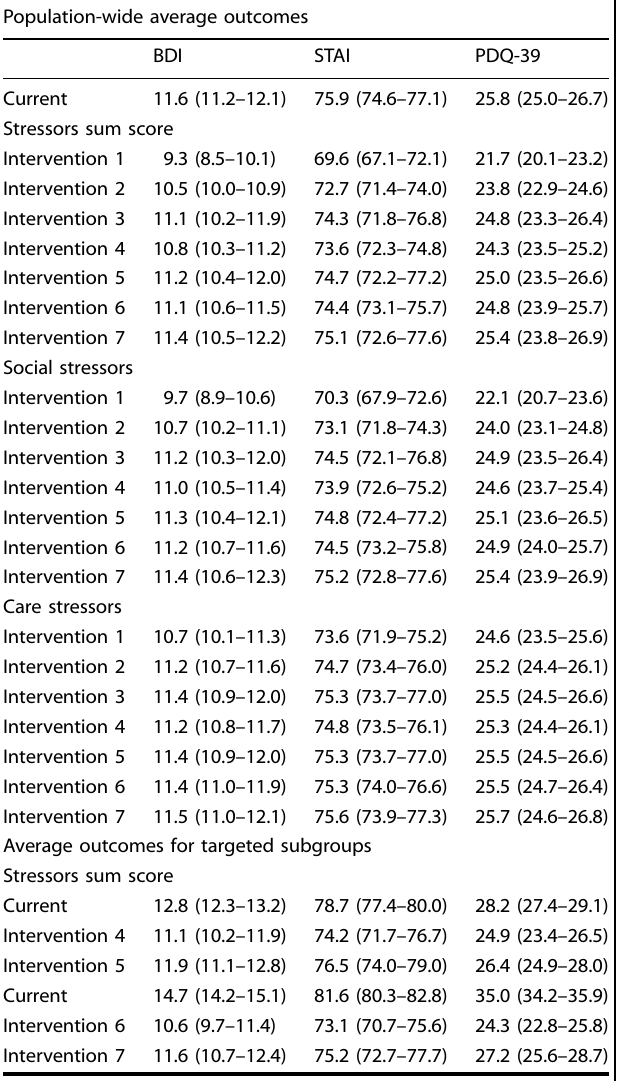
Table 2. Population standardized means for seven hypothetical interventions on COVID-19 related